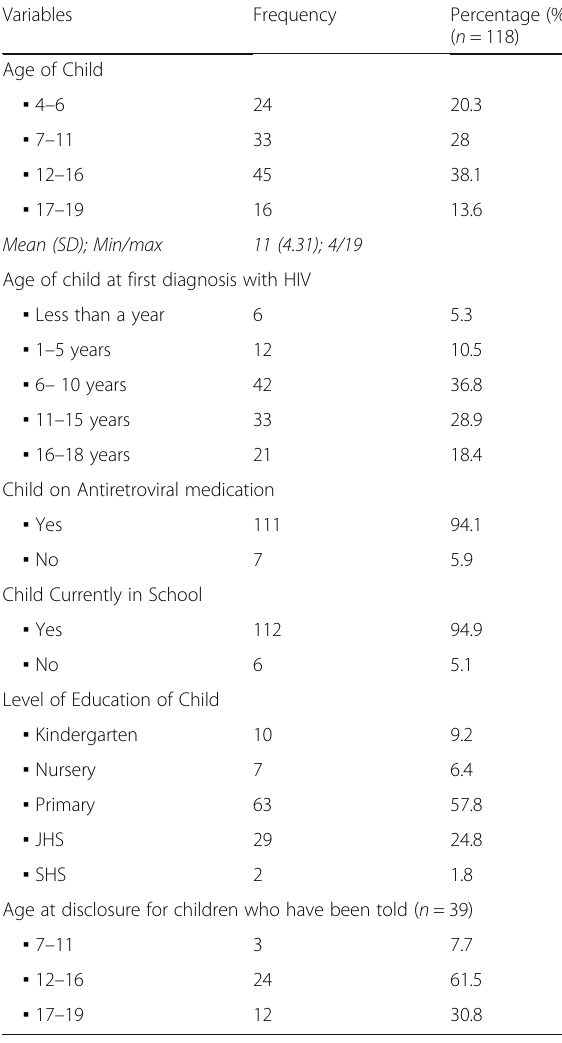
Table 2 Characteristics of Children whose caregivers took part in the study